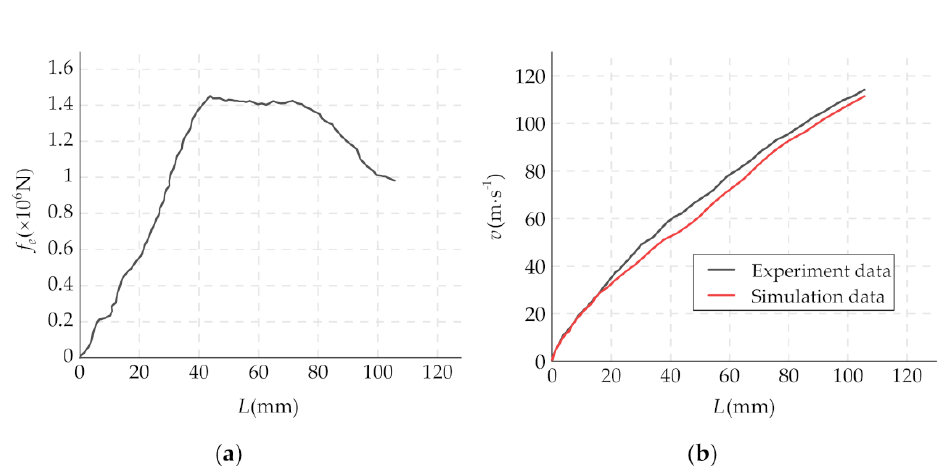
Figure 16. ( a ) Engraving resistance force vs. projectile displacement; ( b ) engraving-completion velocity of the projectile vs. projectile